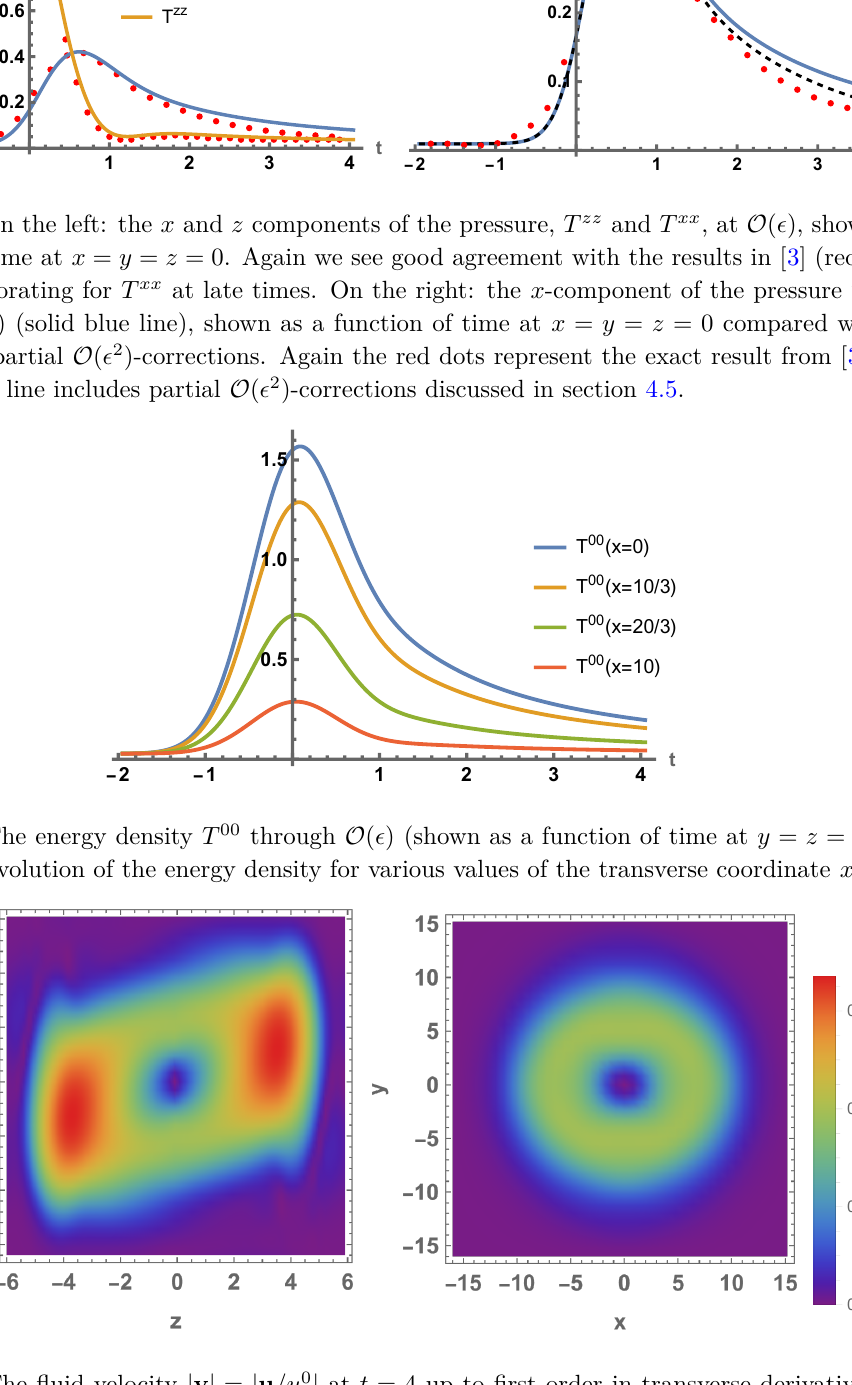
Figure 8 . The fluid velocity | v | = | u /u 0 | at t = 4 up to first order in transverse derivatives. On the left hand side we display the y = 0 slice of | v | , while the right side shows the z = 0